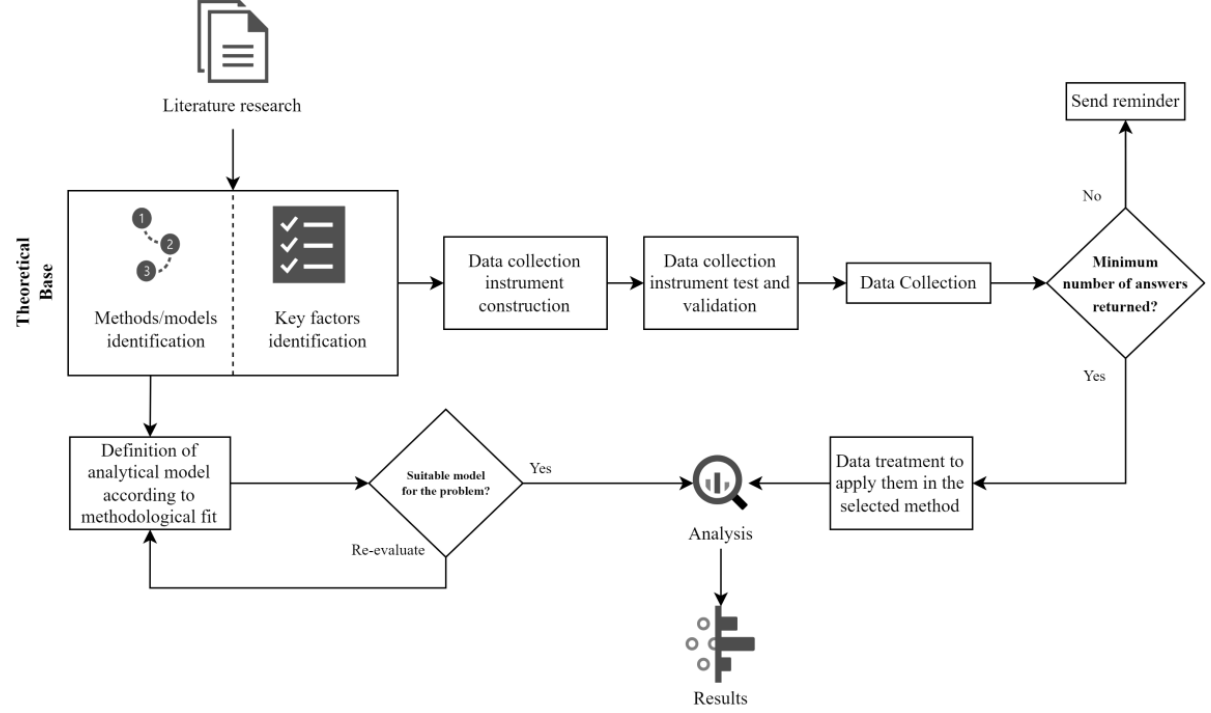
Figure 1. Multicriteria analytical framework flowchart.